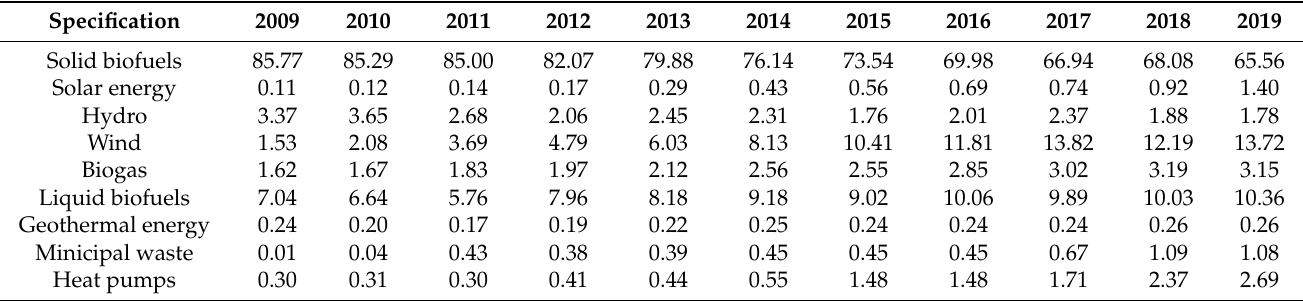
Table 1. The share of renewable energy commodities in the total renewable energy in Poland in the years 2009–2019.